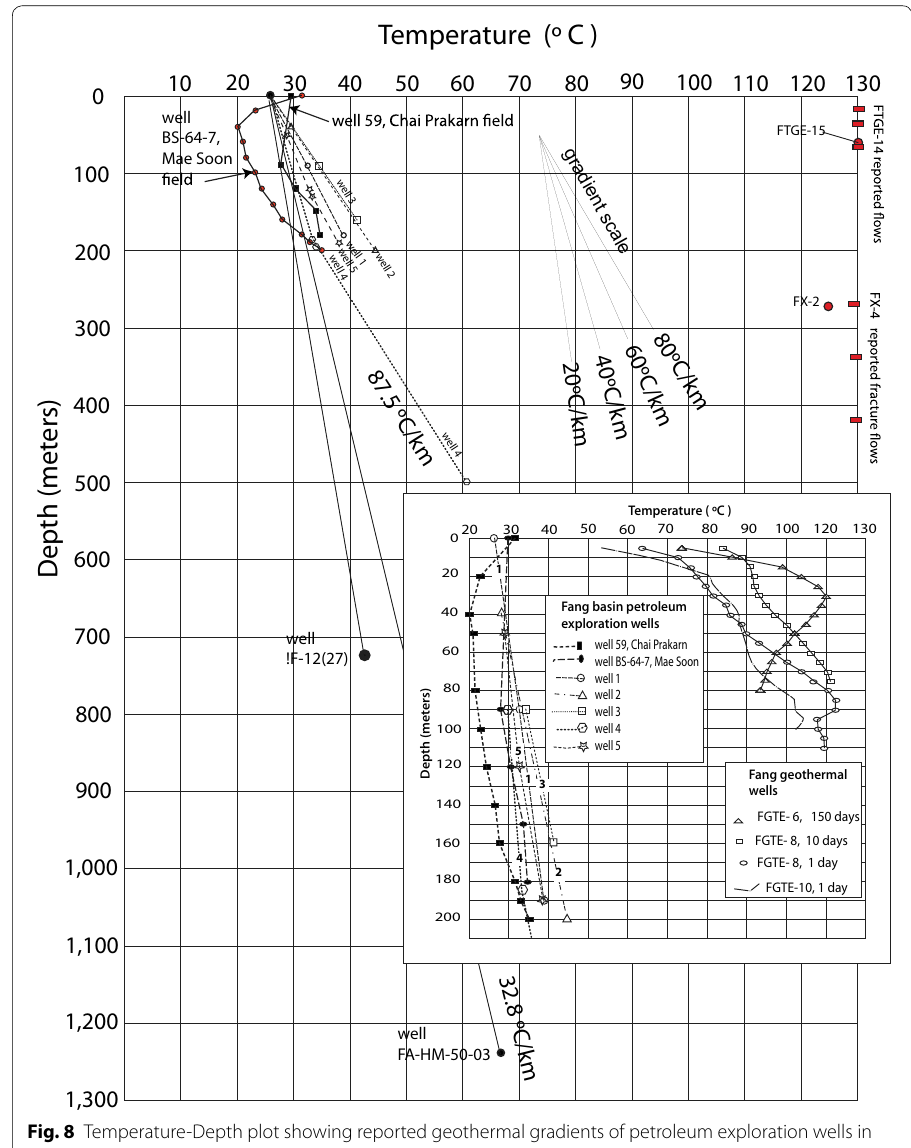
Fig. 8 Temperature-Depth plot showing reported geothermal gradients of petroleum exploration wells in Fang basin sediments and an inset figure showing the only available temperature logs of geothermal wells in crystalline rocks. Large plot: Solid lines connect measurement points (solid dots) of Barr et al. (1979) from wells which are located in oil fields shown in Figs.2, 3 (detailed locations were not published). Dashed lines are gradients in wells (locations in Figs. 2, 3) published by Thienprasert and Raksaskulwong (1984), which we extrapolate upward to an assumed surface temperature of 26 °C. (Because these authors did not publish